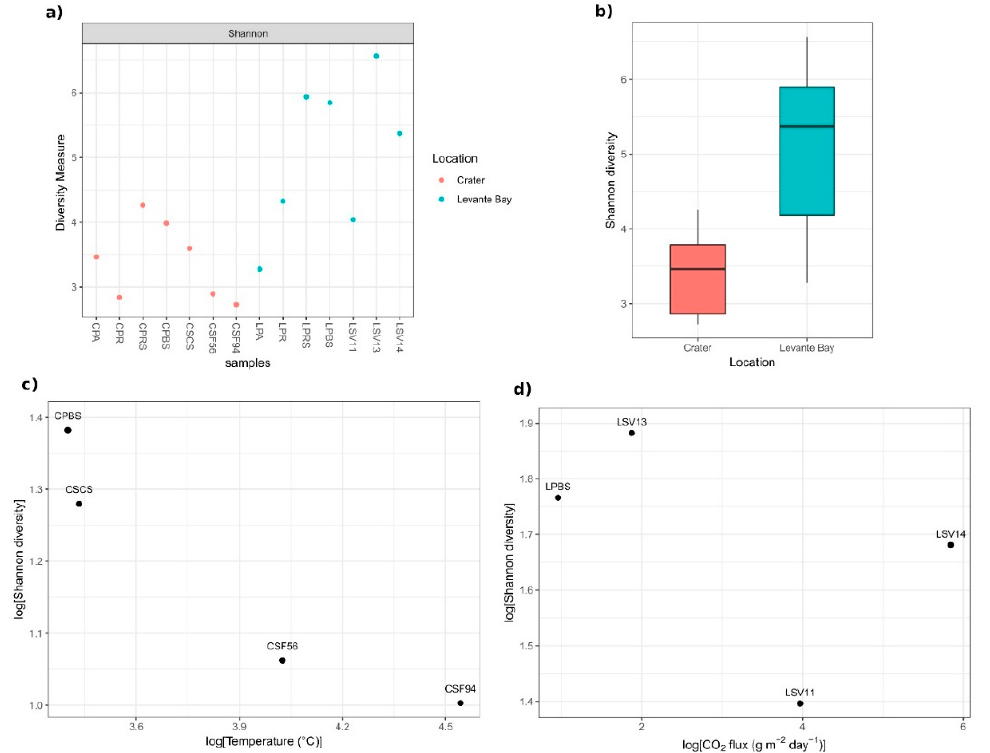
Figure 3. Shannon diversity of samples bacterial communities. ( a ) Samples’ Shannon diversity indices, calculated on raw data; ( b ) box-whiskers plot of the indices based on the different sampling area: Ends of the whiskers represent the lowest and the highest point still within 1.5 of the inter quartile range (IQR); ( c ) relation between Crater samples soil temperatures and Shannon diversity indices (log transformation of the data has been performed); ( d ) absence of correlation between Levante Bay samples CO 2 fluxes and Shannon diversity indices (log transformation of the data has been performed).